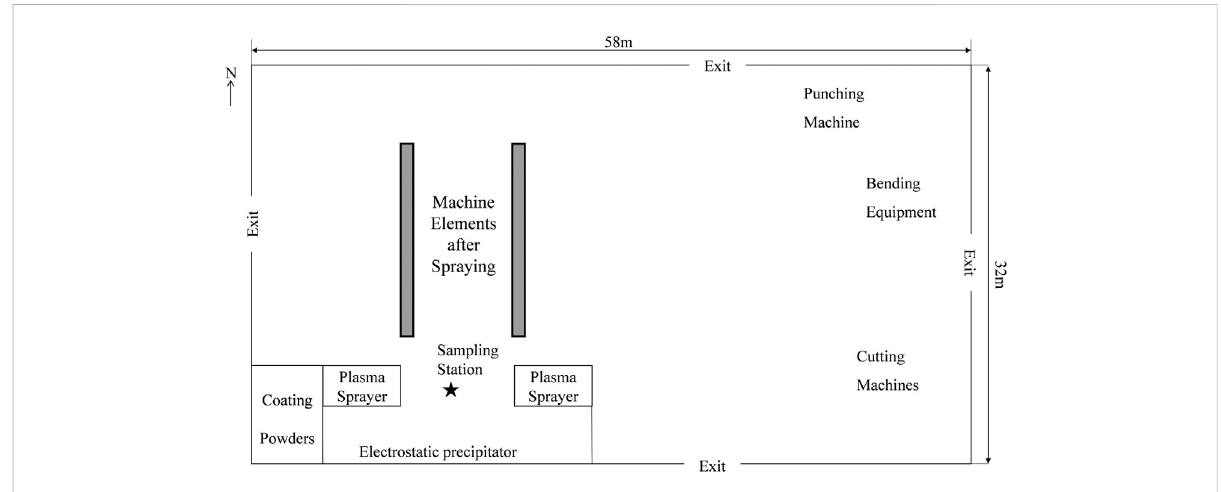
FIGURE 1 A schematic diagram of the powder-coating workshop. The star symbol represents the sampling